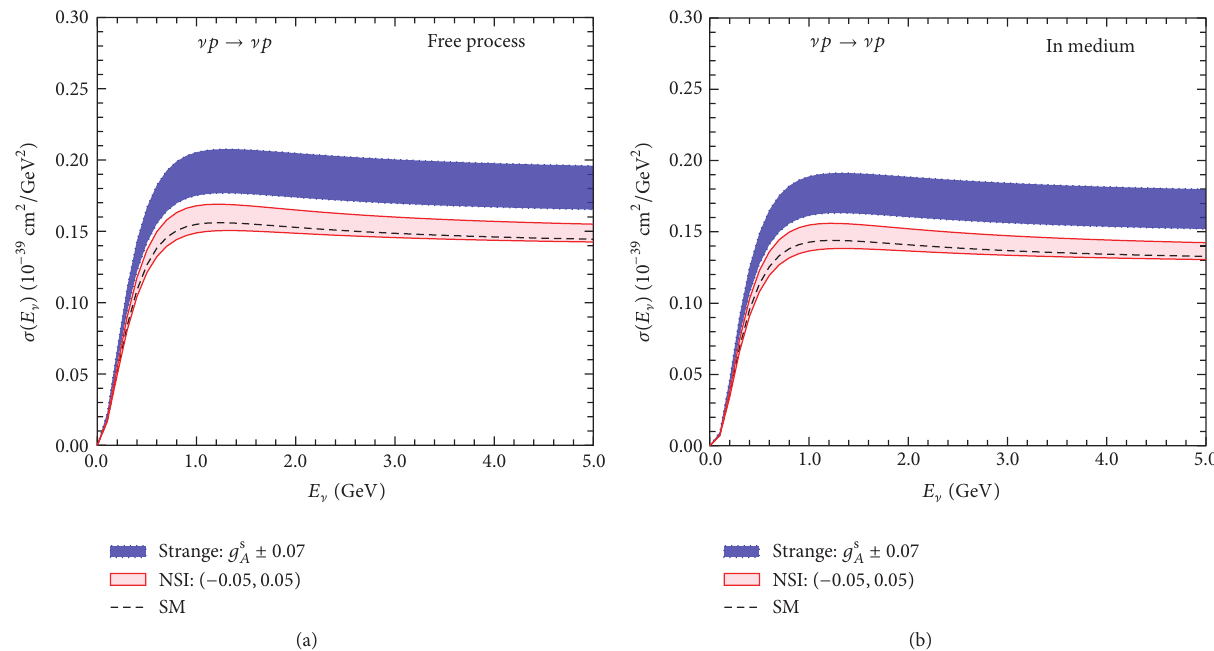
Figure 5: Total integrated ] 𝑝 → ] 𝑝 scattering cross section as a function of the incoming neutrino energy due to SM, strange quark, and NSI scattering. The results refer to scattering on free protons (a) and scattering on bound protons, that is, assuming nuclear effects, at a 12 C detector